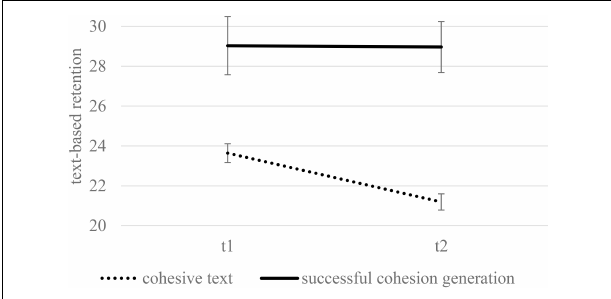
FIGURE 4 | Text-based representation as a function of condition and delay when controlling for reading skills (estimated means and standard errors). In contrast to Figure 1 , only learners who successfully generated (+1 SD) were analyzed. Maximum performance was 38.